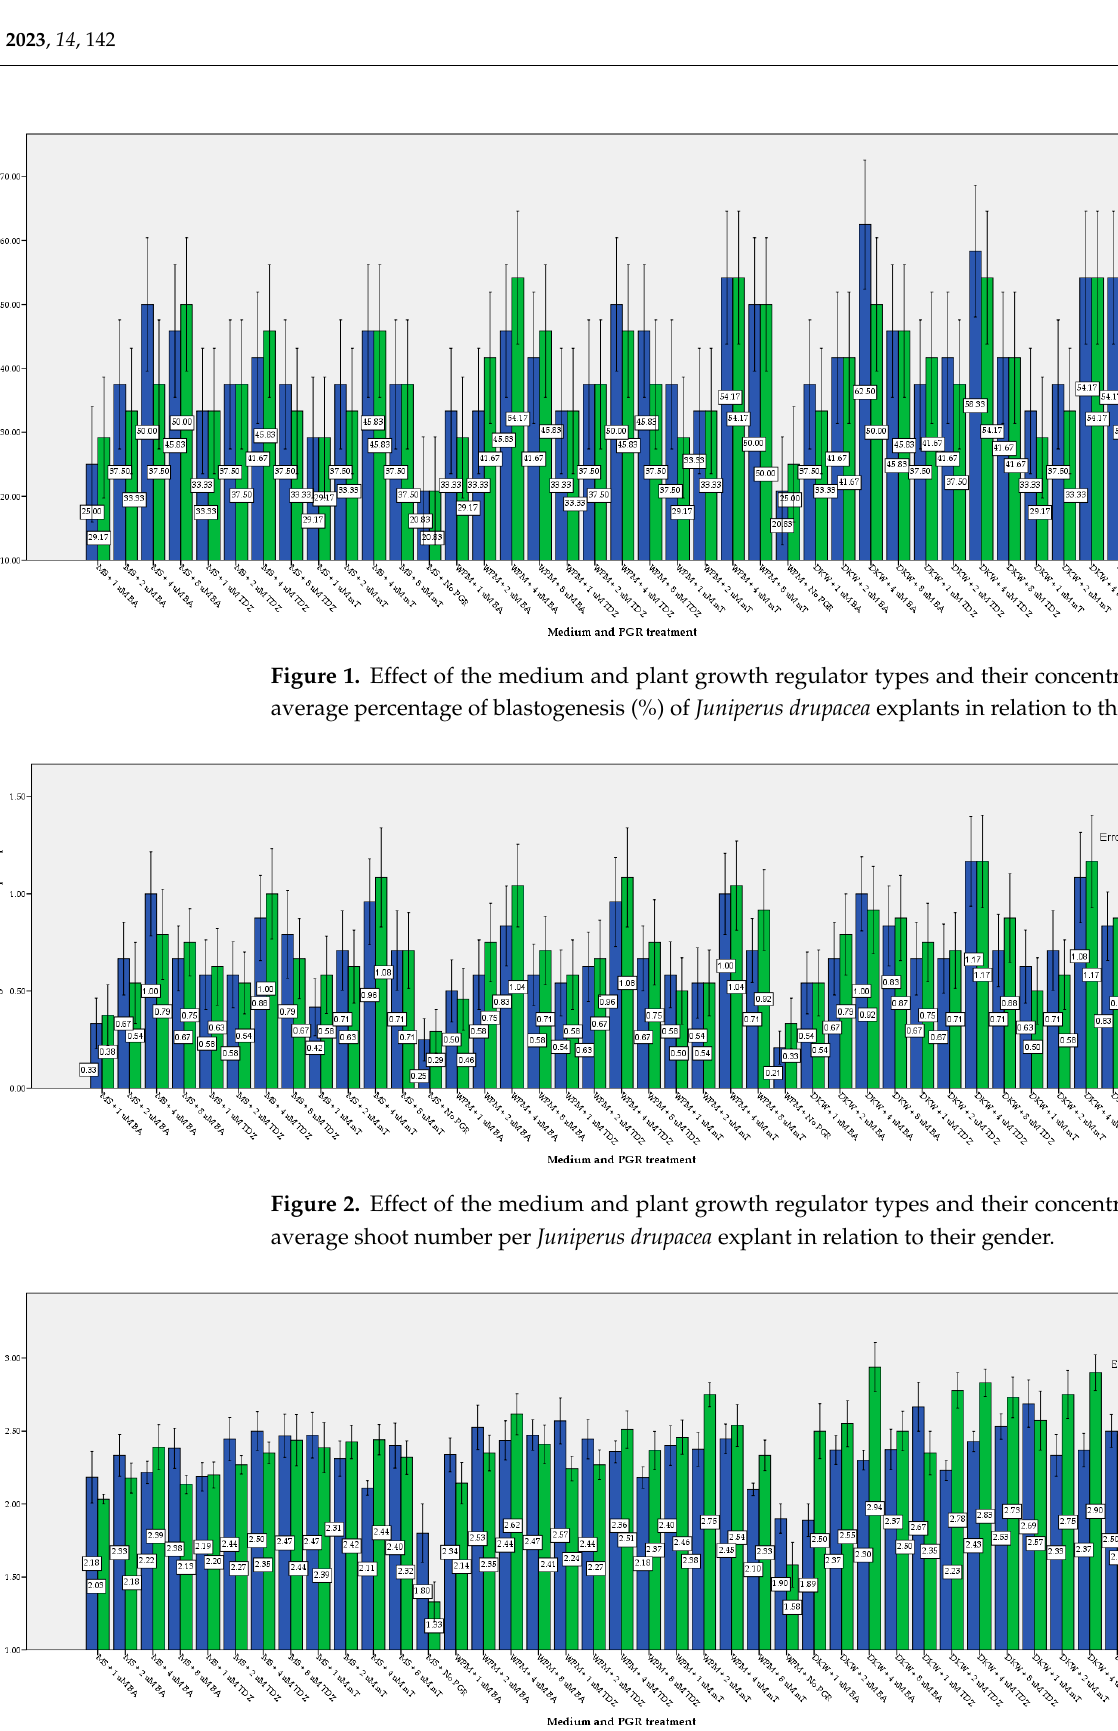
Figure 3. Effect of the medium and plant growth regulator types and their concentrations on the